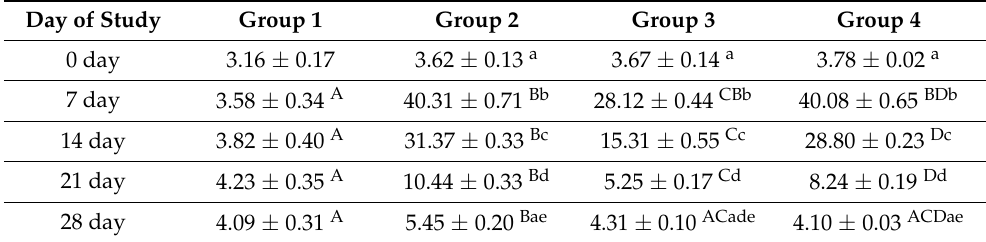
Table 1. Effect of adjuvanted, sonicated antigens on TOS (μmol H 2 O 2 equivalent/L) in rabbits.